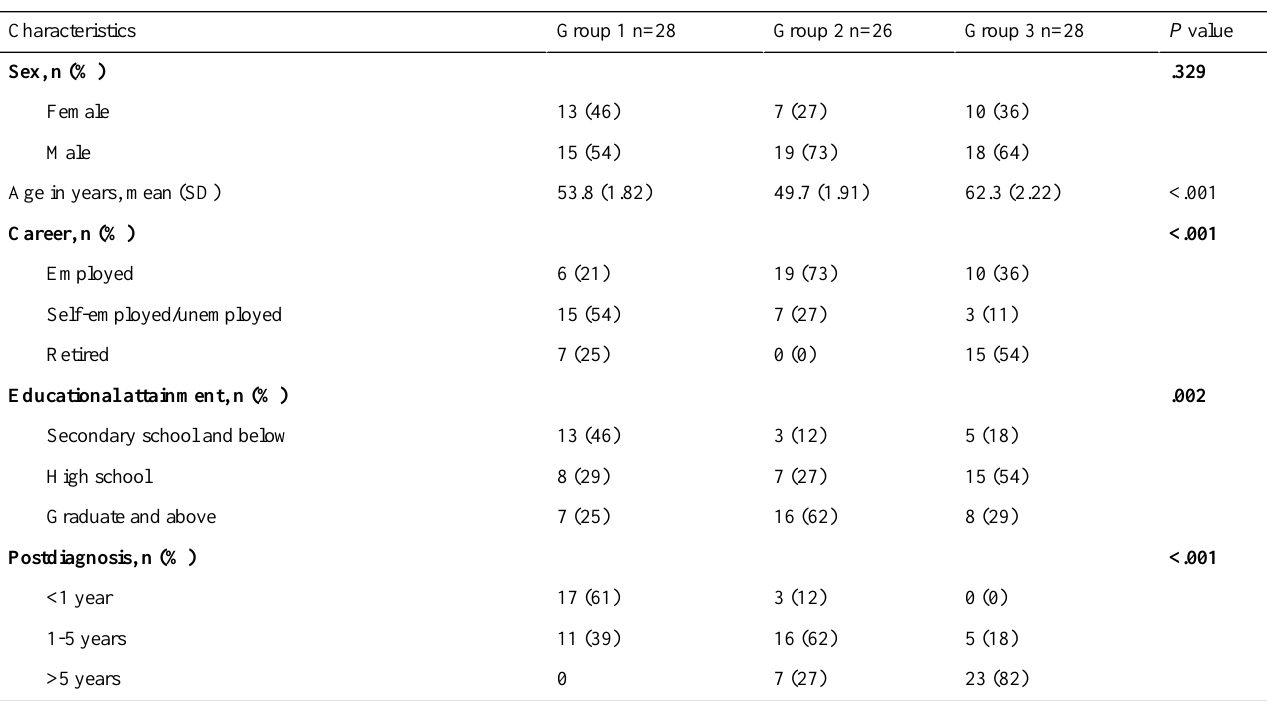
Table 2. Demographic characteristics of different groups.